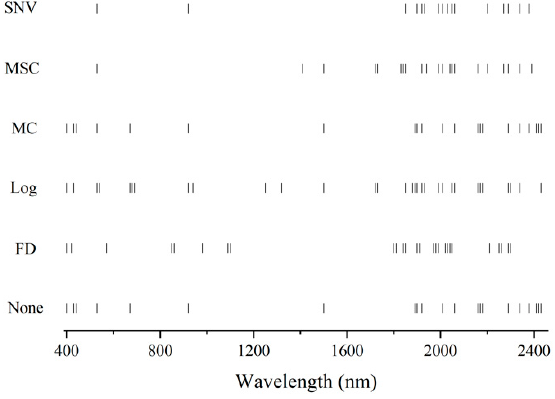
Figure 5. The distributions of spectral variables selected by competitive adaptive reweighted sampling (CARS) with different spectral pretreatments.